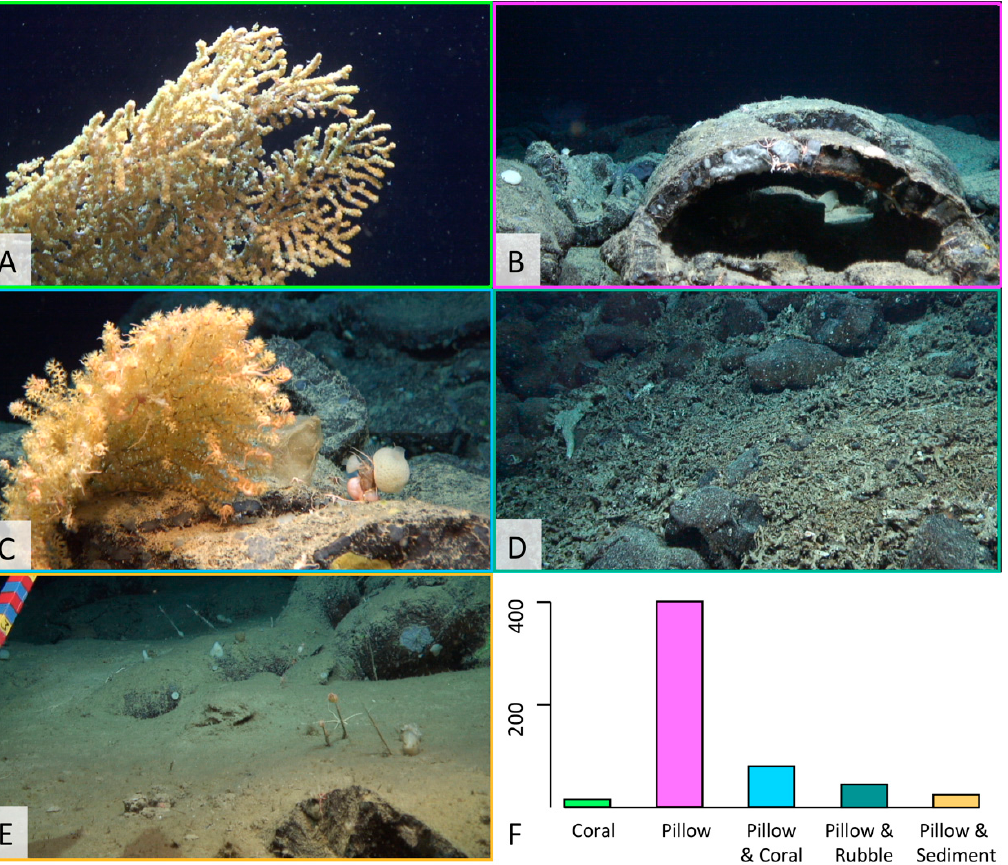
Figure 5. ( A – E ): The images demonstrate a representative of each defined habitat type. ( A ): Coral; ( B ): Pillow; ( C ): Pillow + Coral; ( D ): Pillow + Coral Rubble; ( E ): Pillow + Sediment. ( F ): The bar plot displaying the proportional occurrence of each habitat.